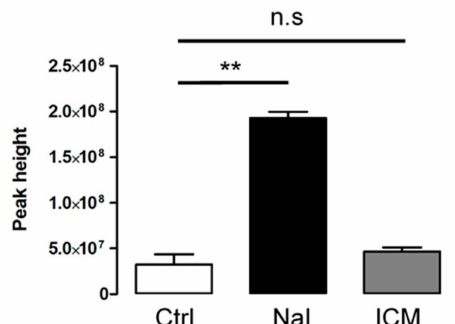
Figure 3. Assessment of iodide concentration through metabolomics comparison between ICM- and NaI-exposed thyroids. Samples for LC-MS measurement are analyzed after metabolites extraction from treated mouse thyroids (24 h after NaI, 48 h after ICM). Iodide concentration was evaluated by peak height from three independent organs. ** p < 0.01; n.s: non statistically